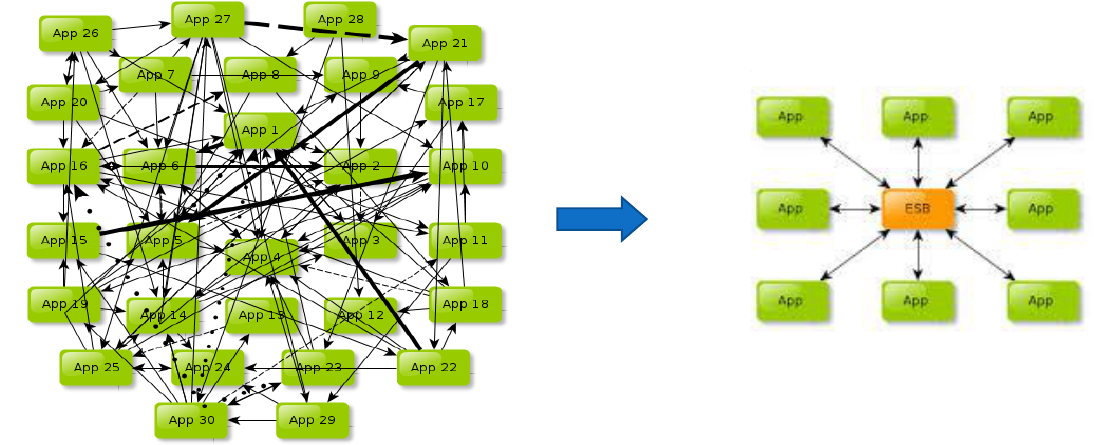
Figure 1: Existing Web Service provision and ESB proposed